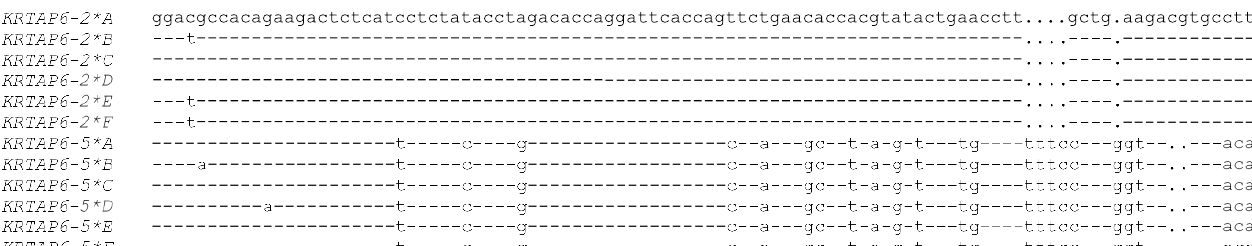
Figure 2. Sequence comparison of variants of ovine KRTAP6-2 and KRTAP6-5 . The nucleotides within the coding region are shown in upper-case text, while those in the flanking regions are shown in lower-case text. Dashes indicate nucleotide sequences identical to the top sequence, and dots have been introduced to improve the alignment. The start and stop codons are shown in bold.